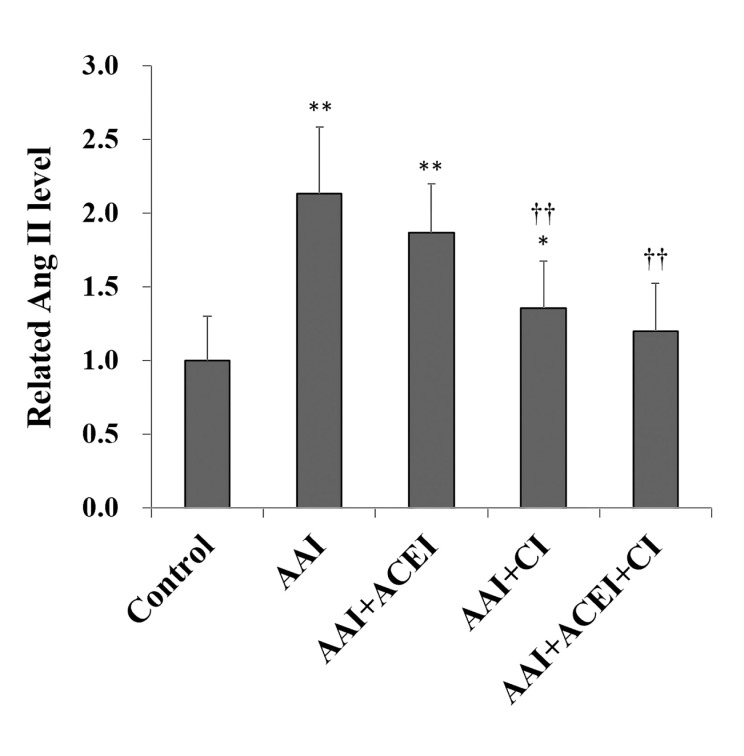
Changes in Angiotensin II (Ang II) in kidneys of mice with AAI-induced acute nephropathy.Renal Ang II levels were determined, and the related activity levels are shown as the levels relative to the Control group. All values are expressed as the means ± SD from each group (n = 9). * and ** indicate p < 0.05 and p < 0.01 compared to the Control group, respectively; †† indicates p < 0.01 compared to the AAI group.